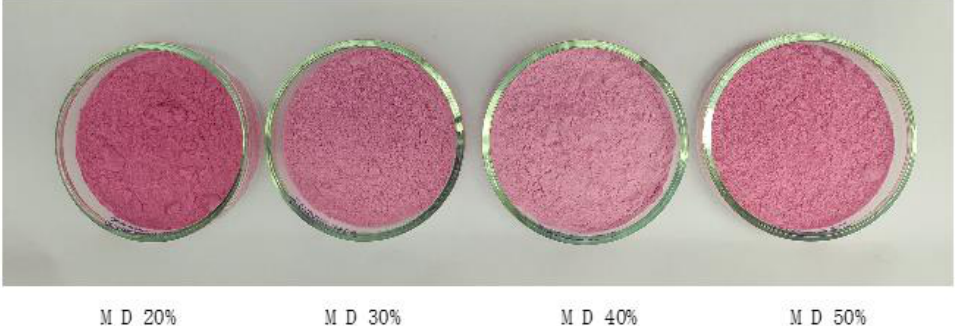
Figure 1. Images of freeze-dried powders obtained using different maltodextrin (MD) concentrations.